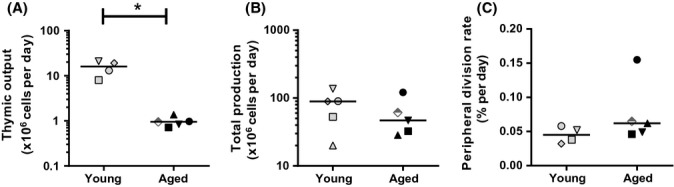
Contributions of daily thymic output and peripheral T-cell division to total naive CD4+ T-cell production. (A) Estimated daily thymic output (cells per day) in young and aged individuals, calculated by multiplying the total daily naive CD4+ T-cell production by the normalized naive CD4+ T-cell TREC content (normalized using TREC contents of single positive CD4+ thymocytes), as described previously (den Braber et al., 2012). The asterisk marks a significant difference (P-value < 0.05) in daily thymic output between young and aged individuals. (B) Total production of naive CD4+ T cells per day in young and aged individuals, calculated as (the average turnover rate p) × (the absolute number of naive CD4+ T cells per liter blood) × (5 L blood) × 50, assuming that 2% of lymphocytes reside in the blood (Westermann & Pabst, 1990). (C) Estimated daily peripheral division rate per cell, calculated by dividing the estimated total peripheral T-cell division (in Fig. S7B) by the total number of naive CD4+ T cells present in the periphery. The normalized TREC content of naive CD4+ T cells in young individuals was previously reported in den Braber et al. (2012); as no TREC measurements were obtained for individual C, this individual was not included in the analysis. TREC contents are shown in Fig. S7A. Different symbols indicate different individuals. The elderly male who tested seropositive for CMV is depicted by a semi-filled diamond.